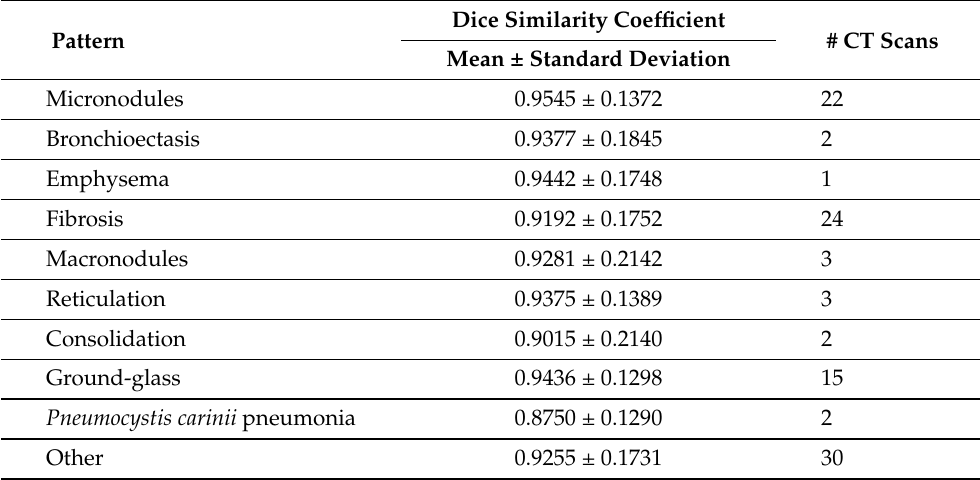
Table 5. Results obtained for the patterns included in the HUG-ILD dataset. The row “Other” refers to scans that presented more than one